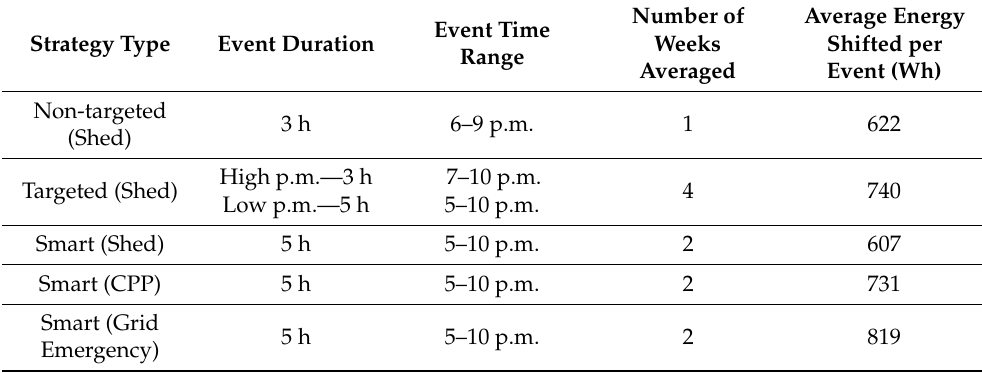
Table 9. Afternoon Energy